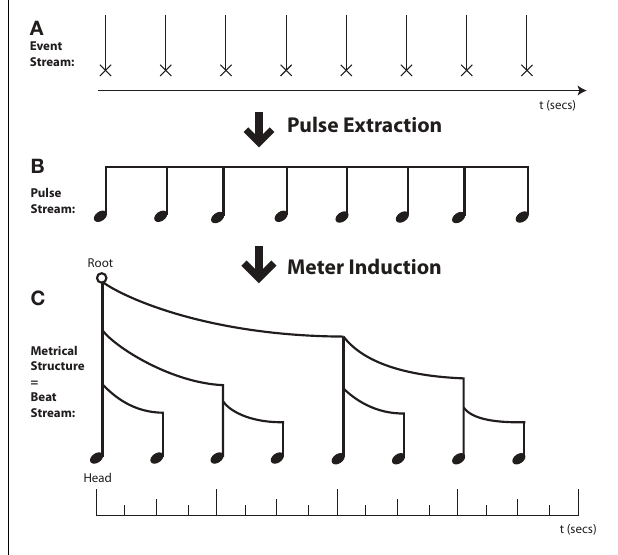
FIGURE 1 | Musical Rhythms are Trees in Time. (A) Rhythmic processing starts with an unprocessed sequence of auditory events. (B) “Pulse Extraction” —Cognitive processes lead to conversion of a periodic event sequence to an (unaccented) isochronic pulse stream. (C) “Meter Induction” —Cognitive processes lead to conversion of an event stream or unaccented pulse stream to a hierarchically-grouped metrical tree structure. The height of each metrical stem indicates the relative prominence of that event, while the curved beams indicate grouping structure. Note that while pulse extraction and meter induction are typically combined in music, these are separate cognitive processes. A pulse can be extracted without any definite meter assignment (e.g., in metrically ambiguous sequences), and meter can be inferred in the absence of isochrony (e.g., in spoken language and